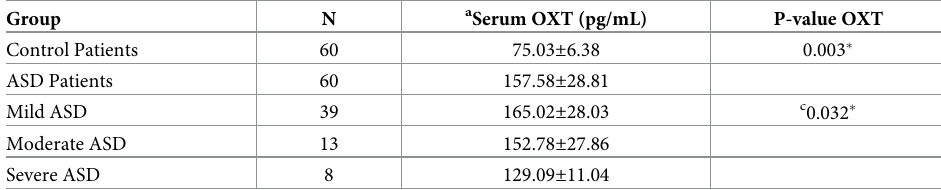
a Normality tested using Kolmogorov-Smirnov test: controls (0.055), ASD (0.072), mild ASD (0.21), moderate ASD